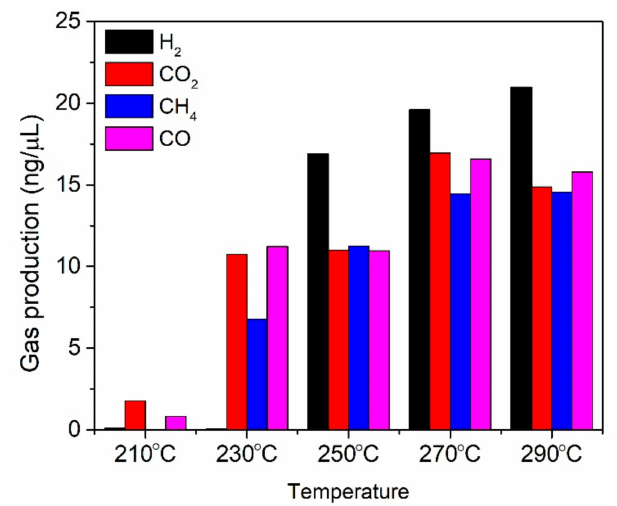
Figure3. Total yieldsyngas production at60 min ofpyrolysistime asa function ofpyrolysistemperature.